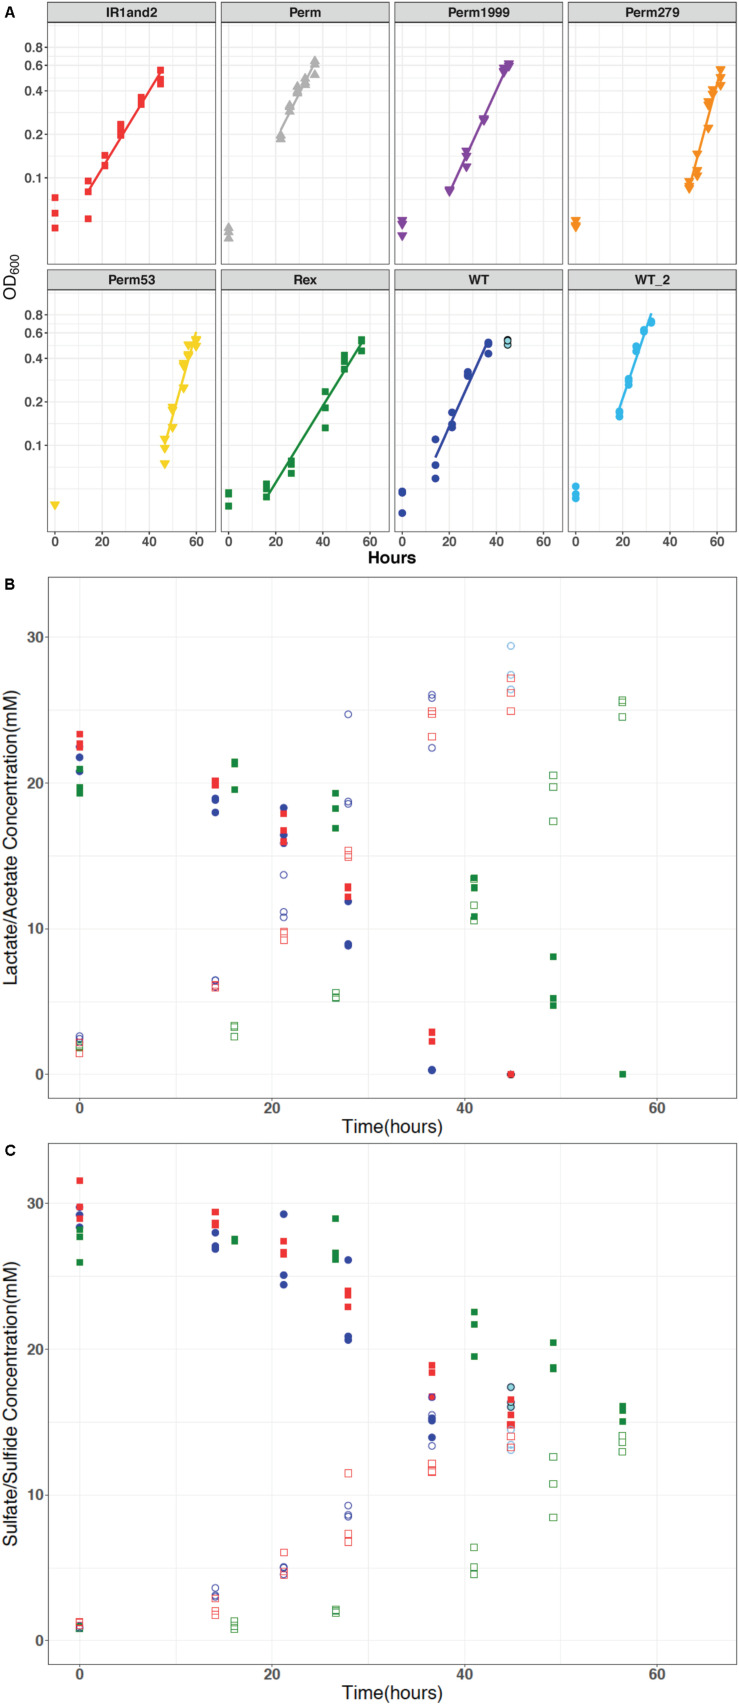
(A) Optical density measured at 600 nm (log scale) plotted against time for all DvH strains: wild type (WT and WT2), triple permease knockout (ΔPerm), and the three individually expressed permeases: Perm53, Perm279, and Perm1999, Rex-promoter Sat mutant (IR1and2), and Rex mutant (Δrex), which show similar growth characteristics. (B) The representative concentrations of lactate and acetate versus time. These concentrations changed relative to sulfate as predicted by equation 1. (C) Representative concentrations of sulfate and sulfide for all strains were similar, varied inversely throughout the experiment as expected, and maintained mass-balance. The data for WT, IR1and2, Δrex are in dark blue, red, and green, respectively. In all panels, the stationary phase time points for the wild type are indicated in light blue.